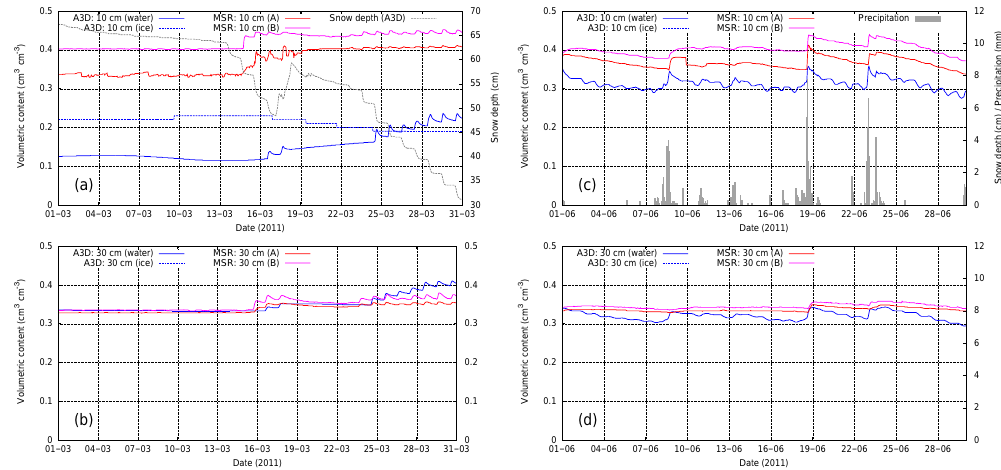
Figure 7. Measured (MSR) and simulated (A3D) soil moisture at the IRKIS station SLF2, for 10cm depth (a, c) and 30cm depth (b, d) , during the snowmelt season (a, b) and a snow-free summer month (c, d) . Panel (a) additionally shows simulated snow depth and panel (c) additionally shows